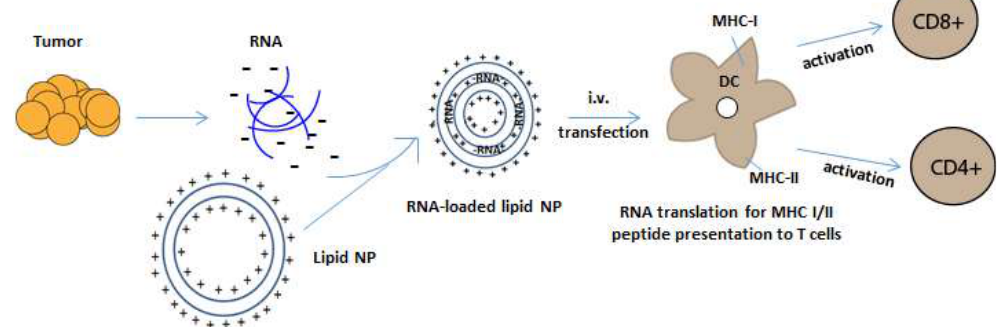
Figure 2. RNA-NP mediated transfection of APCs. Negatively charged tumor mRNA is extracted and amplified from personalized tumor biopsies and is encapsulated into positively charged lipid-NPs. NPs encapsulate RNA through electrostatic interaction and are taken up by dendritic cells in reticuloendothelial organs after systemic administration. The RNA is then translated and processed by an APC’s intracellular machinery for the presentation of peptides onto MHC class I and II molecules, which activate CD4 and CD8+ T cells.